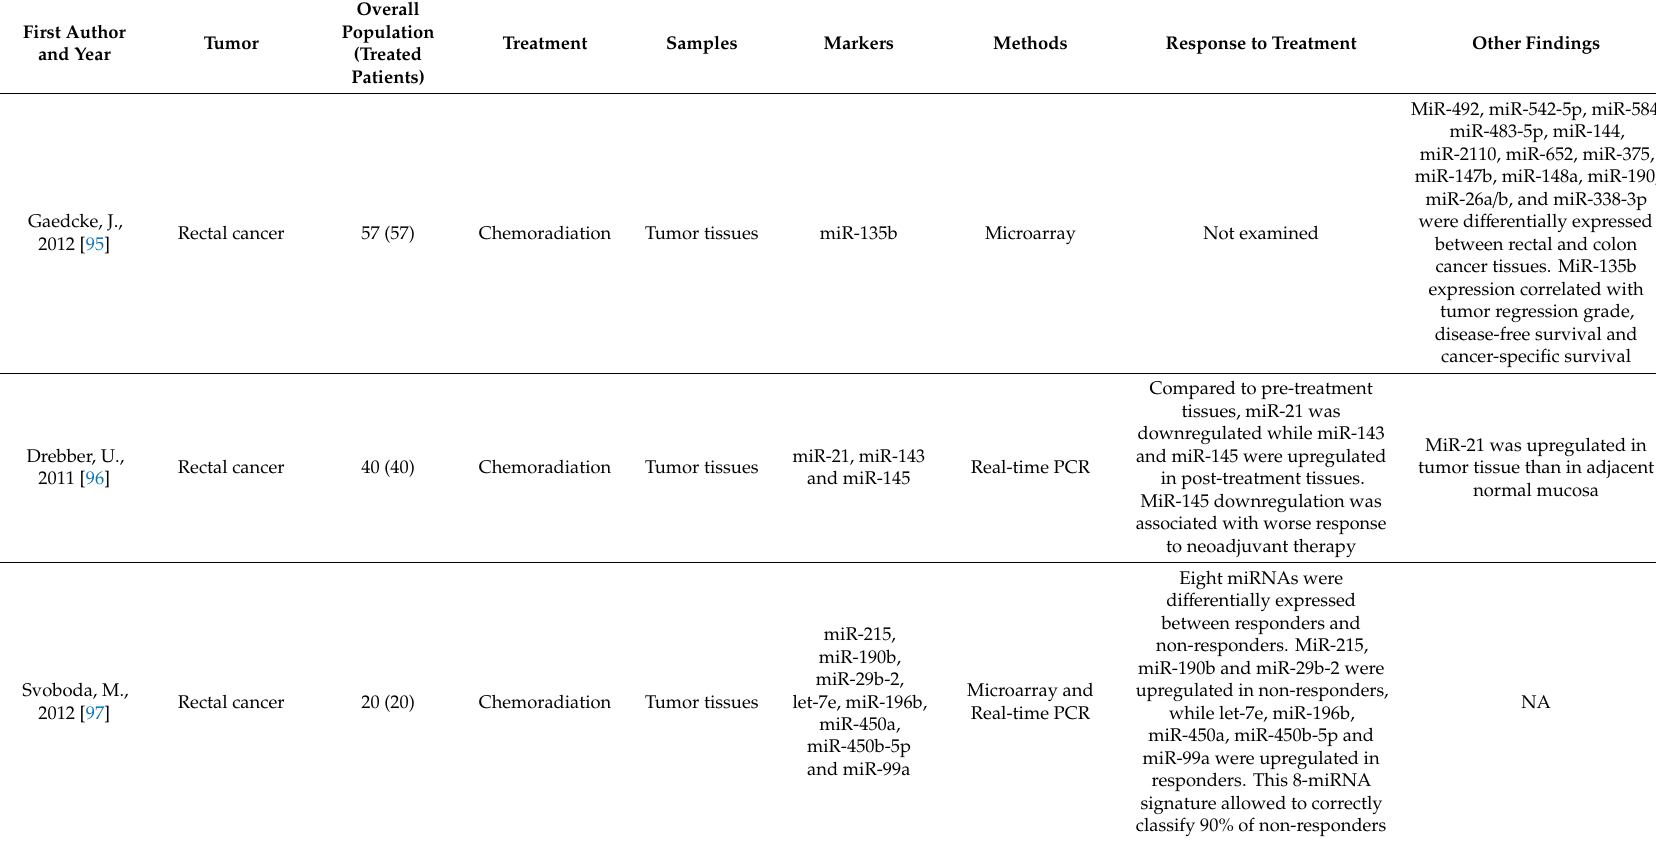
Table 8. MiRNA signatures in rectal cancer patients receiving neoadjuvant